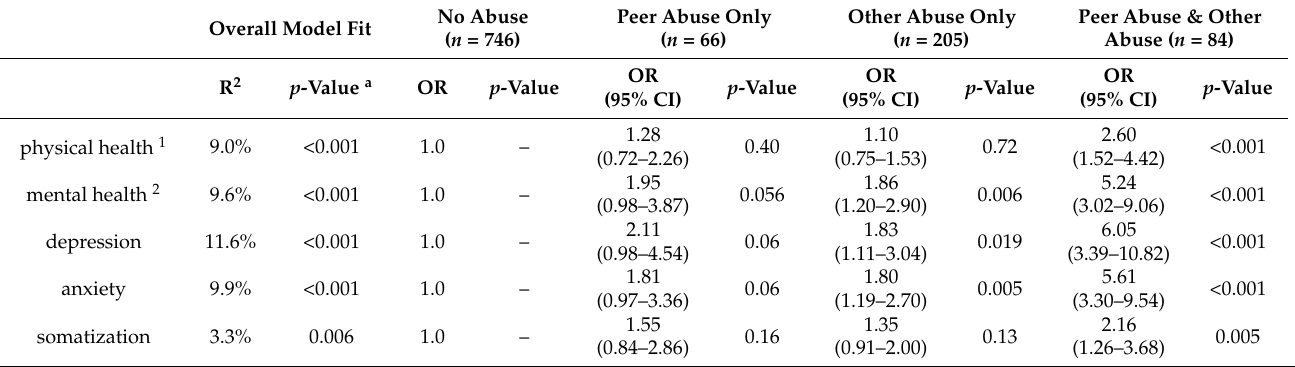
Table 2. Sex-specific adjusted logistic regression analyses for male patients ( n = 1101), showing the influence of ACEs and peer abuse on physical and mental health